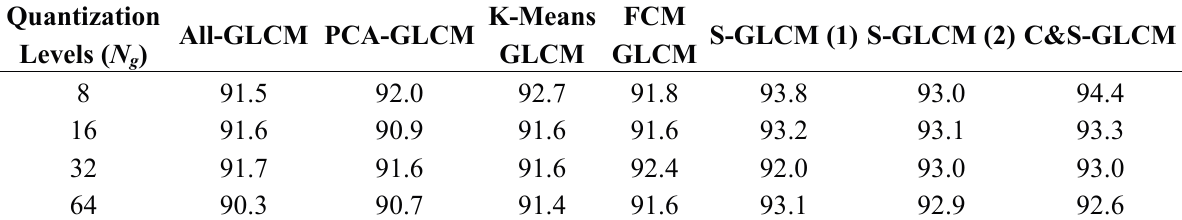
Table 9. The average accuracies (OA%) of each texture classification algorithm with the various quantization levels for the QuickBird Wuhan dataset.